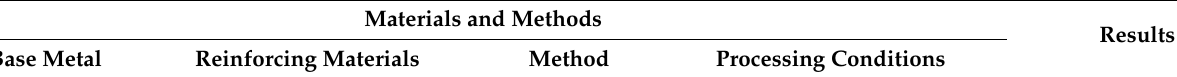
Table 6. Summary of experimental conditions and main results of SHS/casting processing using Cu-Ti-B 4 C and Cu-Ti-C powder